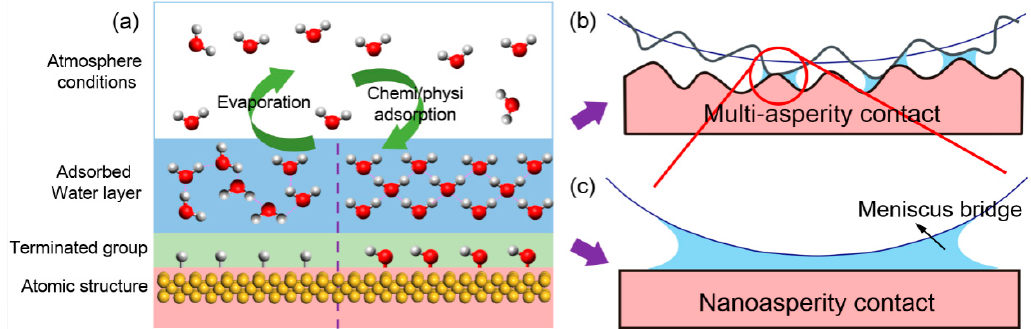
Figure 1. ( a ) The molecular configuration of adsorbed water layer on solid surfaces is governed by atomic structure of substrates, terminated groups on solid surfaces, and atmosphere conditions. A dynamic equilibrium exists in adsorbed water layer on solid surfaces with continuous evaporation and chemi/physi adsorption. ( b , c ) Schematically showing meniscus bridge formation at contacting and near-contacting asperities at multi-asperity contact and at single nanoasperity contact, which strongly affects the interfacial forces (i.e., adhesion force and friction force). The single-asperity contact in ( c ) is also regarded as a microscopic prospective of the multi-asperity contact in ( b ).